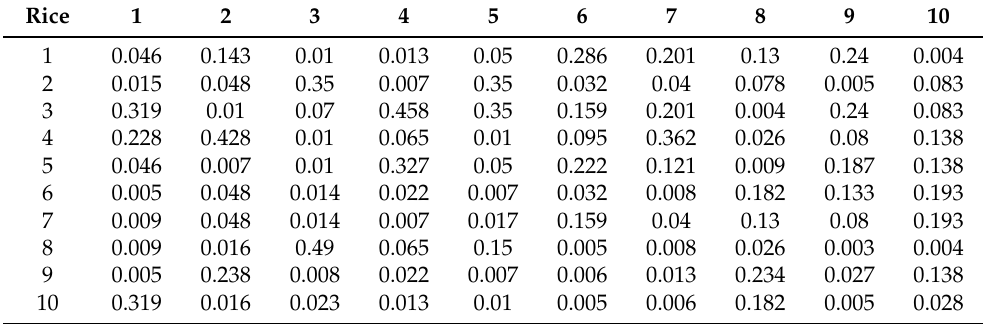
Table A15. Normalization matrix of rice.